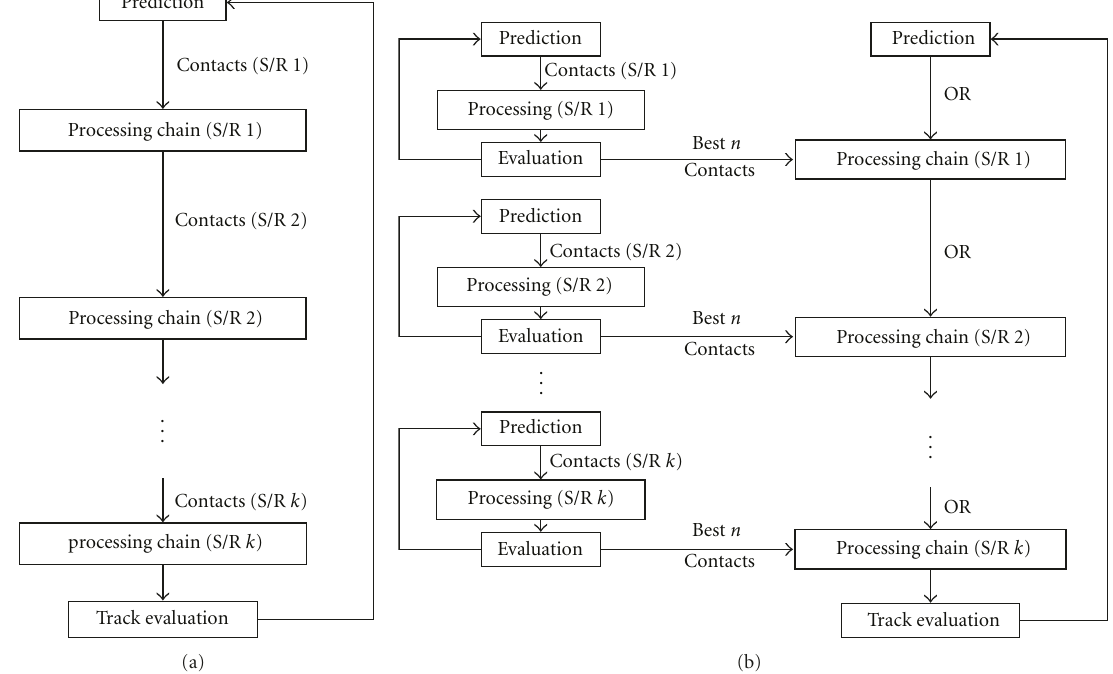
Figure 8: Visualisation of the “AND” (a) and “OR” (b) fusion strategy. A processing chain in the MHT framework contains updating of hypotheses by available contact information and hypotheses reduction